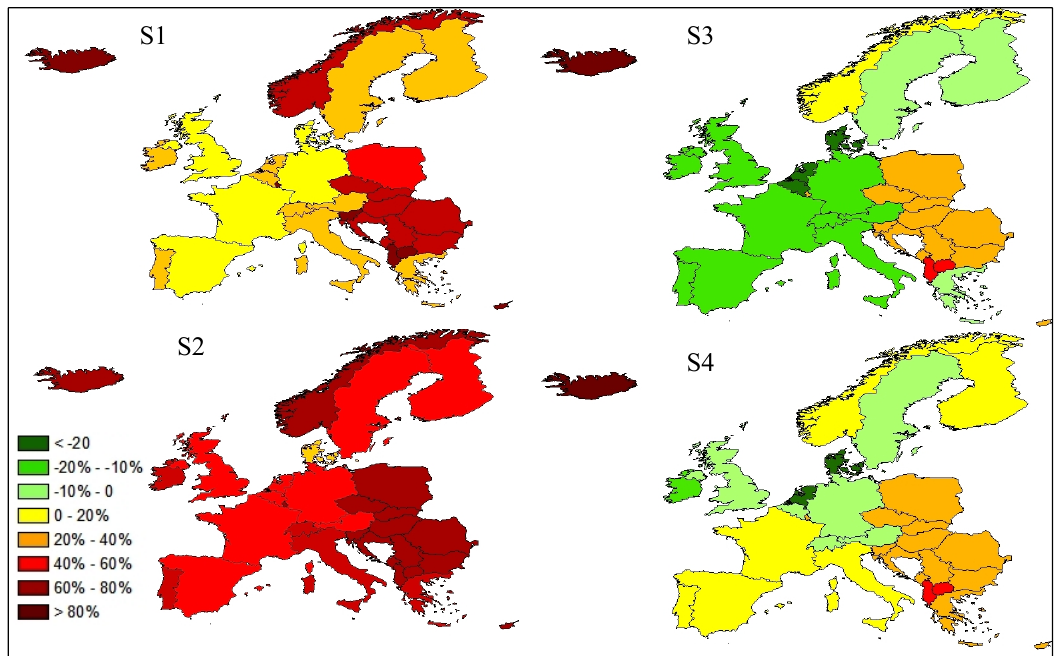
Figure 2. Percentage change of the WF of total production relative to 2000.